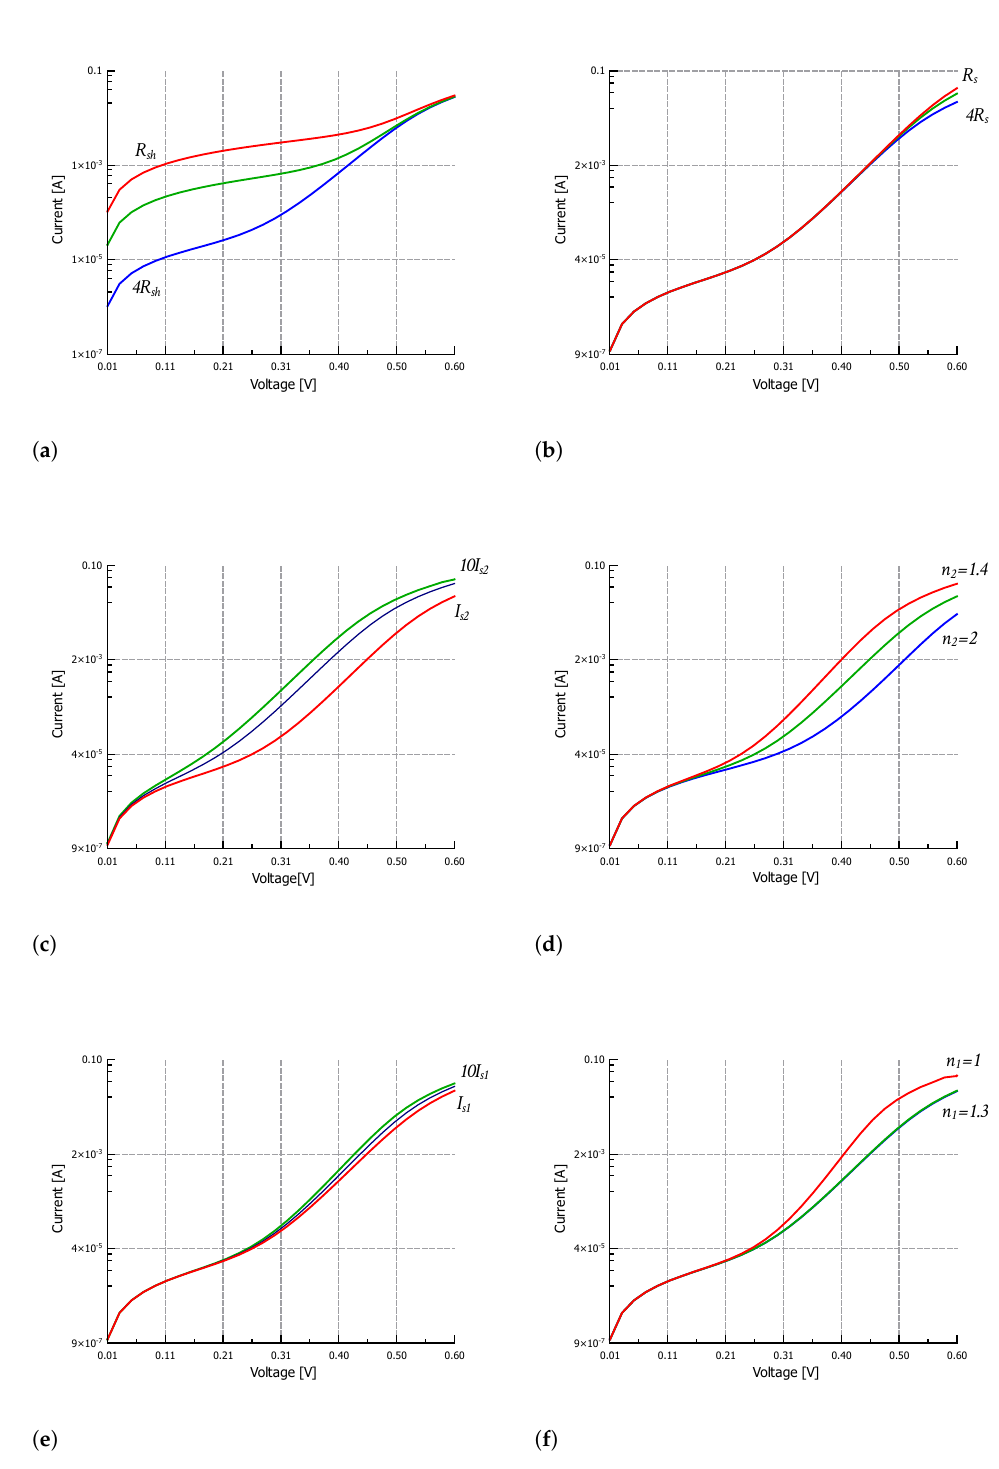
Figure 4. Dark I-V characteristic variation for: ( a ) R sh variation, ( b ) R s variation, ( c ) I s 2 variation, ( d ) n 2 variation, ( e ) I s 1 variation and ( f ) n 1